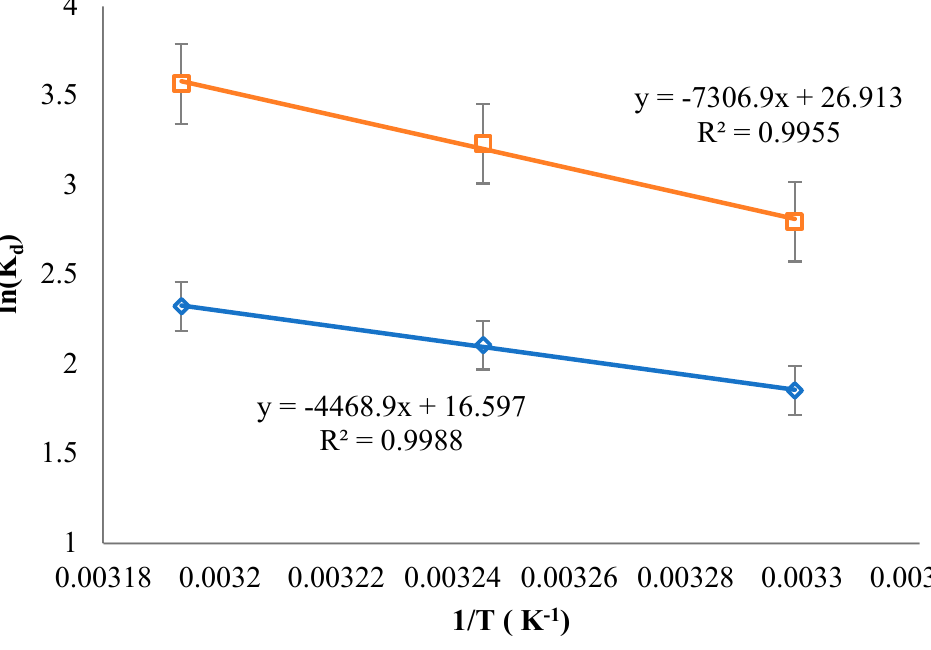
Figure 12. Thermodynamic study for NBB and CV dyes onto ACOC.